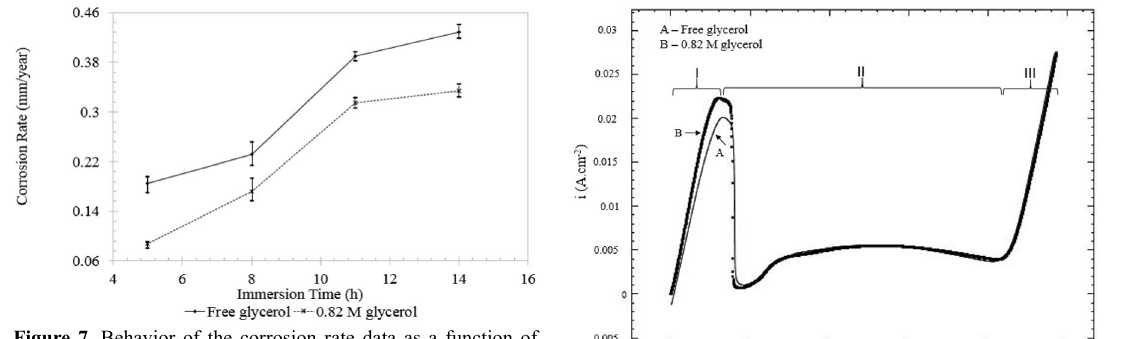
Figure 7. Behavior of the corrosion rate data as a function of immersion period for the concentrations of 0.82 M glycerol and glycerol bath free